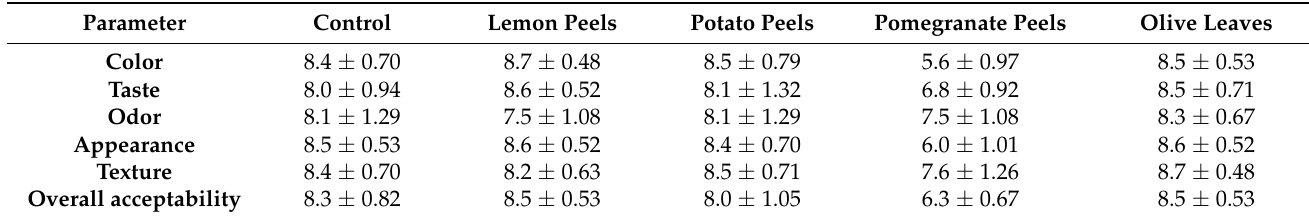
Table 4. Sensory profile of control and treated potato fried